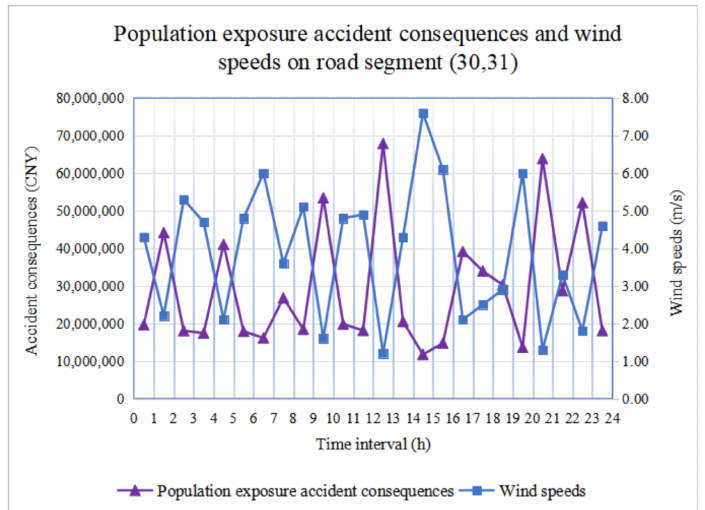
Figure 9. Population exposure accident consequences and wind speed in road segment (30,